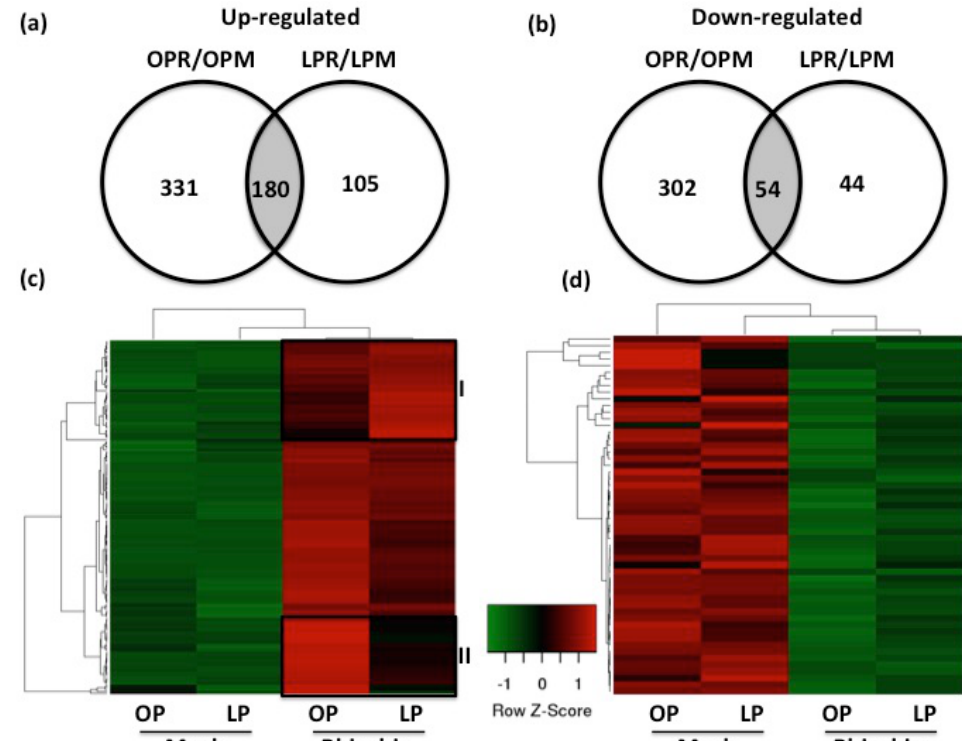
Figure 5. Expression of rhizobia-responsive genes is affected in Pi-deficient common bean seedlings. Number of over-lapping and non-overlapping up-regulated ( a ) or down-regulated ( b ) rhizobia-induced genes among common bean seedlings grown under OP or LP conditions and inoculated with rhizobia (R) or mock (M) during 48 h. Differentially regulated genes in each Pi conditions were identified by Cuffdiff at false discovery rate (FDR) < 0.05, with an additional cutoff of two-fold in a pairwise comparison between treatments (e.g., OPrhizobia/OPmock). Over- and non-overlapping genes were identified after a pairwise comparison between the differentially regulated genes identified in each Pi conditions. A heat map showing the expression levels of up-reguled genes ( c ) or down-regulated genes ( d ) from common bean seedlings growing under OP or LP conditions and inoculated with mock or rhizobia. Expression levels were false colored. Genes showing higher expression levels are shown in different scales of red color, whereas genes showing lower expression levels are showed in different scales of green color.